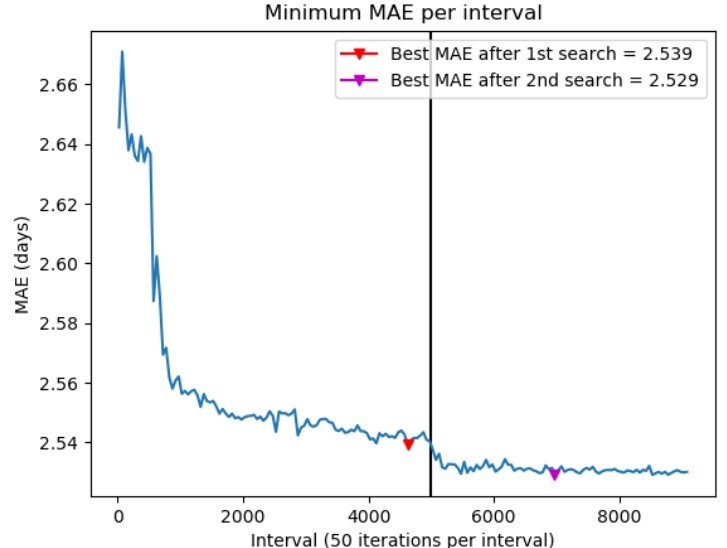
Figure 3. Evolution of minimum MAE across 50 iteration intervals.